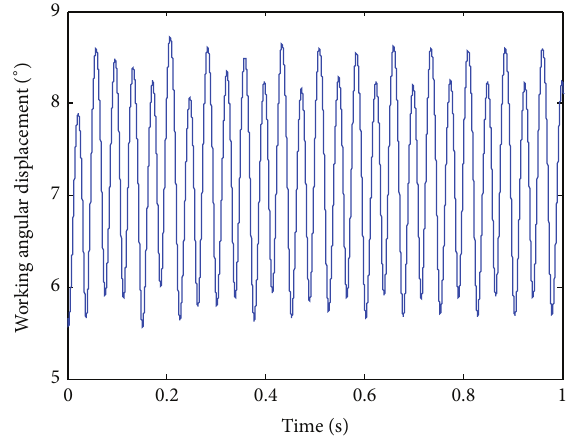
Figure 26: Working AD of the clutch damper.